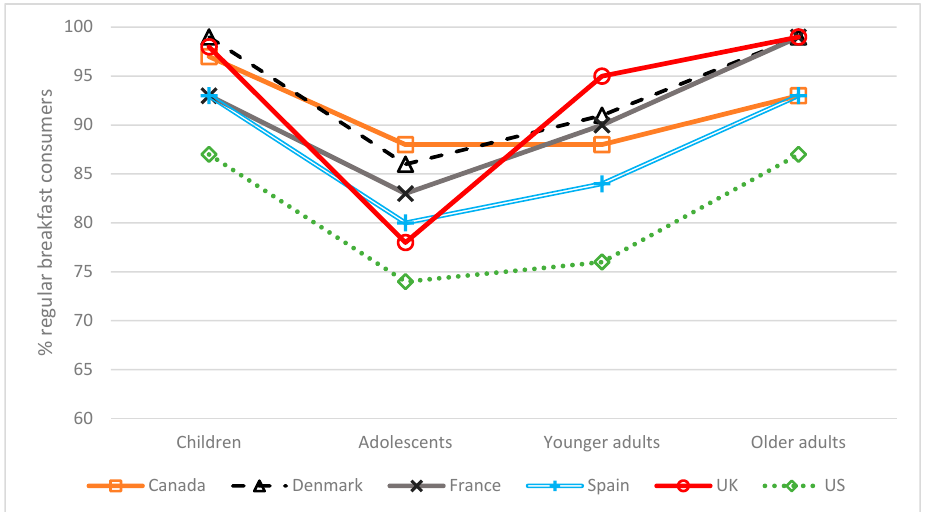
Figure 1. Proportion of regular breakfast consumers by country and age group Regular breakfast consumption was defined as follow: Canada–consumed breakfast on the recall day; Denmark and France–consumed breakfast ≥ 5 days out of 7; Spain–consumed breakfast 3 out of 3 days; UK-consumed breakfast ≥ 3 days out of 4; US-consumed breakfast with more than 50 kcal on the recall day. Age groups were defined as follow: Children (6–12 years, except Spain 9–12 years and UK 5–12 years); Adolescents (13–17 years, except UK 13–18 years); Younger adults (18–54 years, except UK 19–